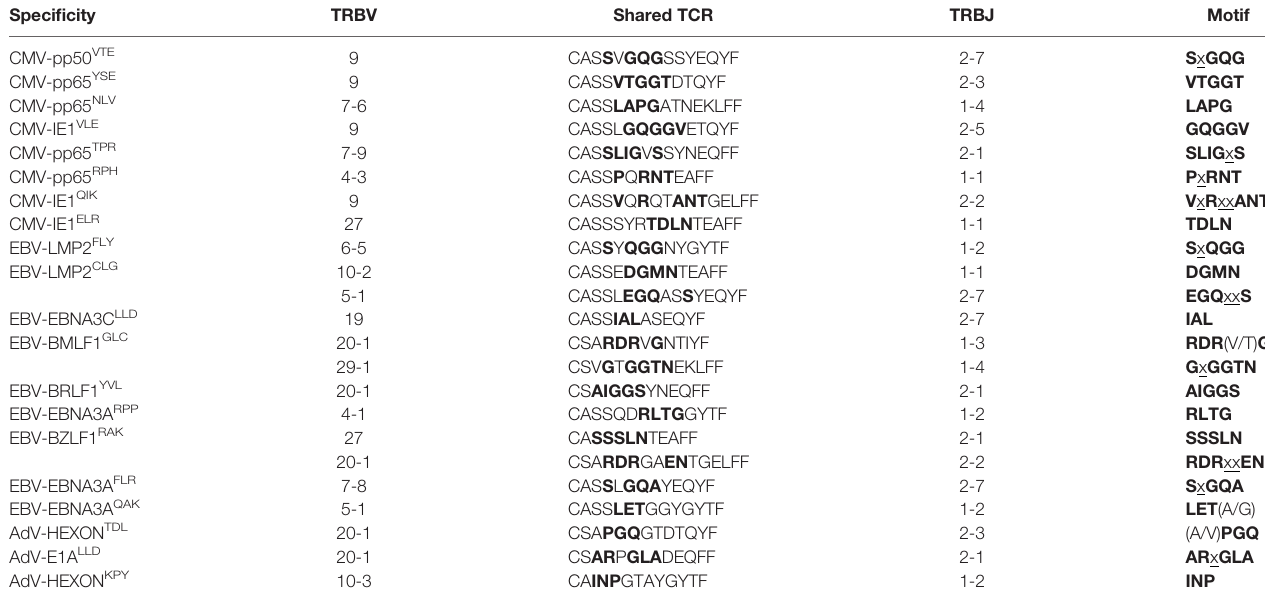
TABLE 3 | Conserved motifs that predict the speci fi